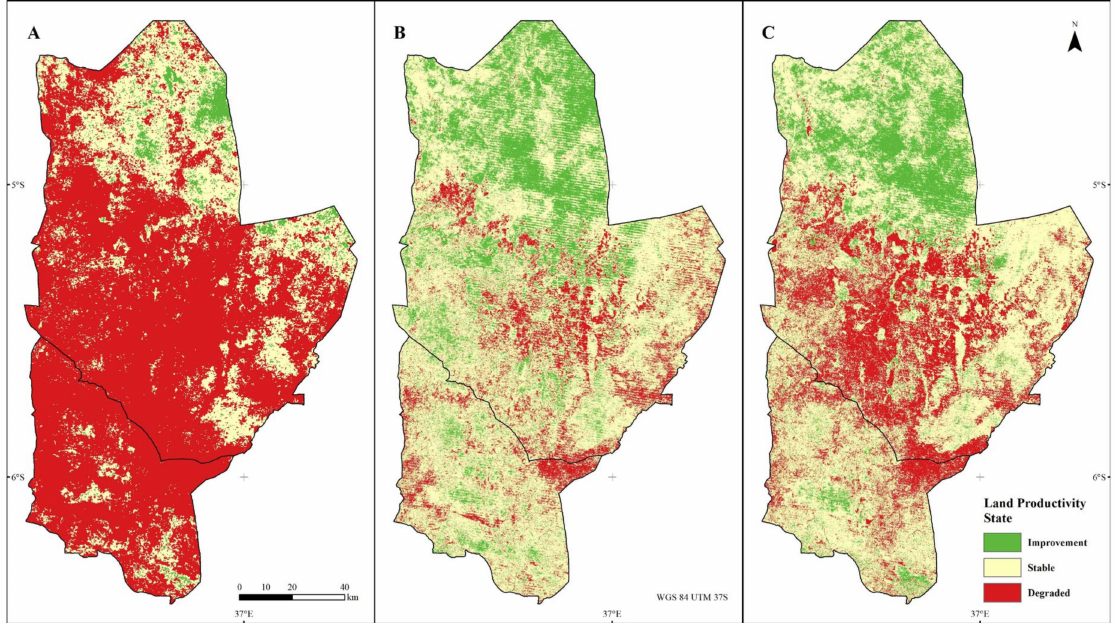
Figure A2. The land productivity component state generated using ( A ) the default approach with MODIS imagery, ( B ) the adapted approach with Landsat imagery for the baseline period, and ( C ) the adopted approach with Landsat imagery for the monitoring period